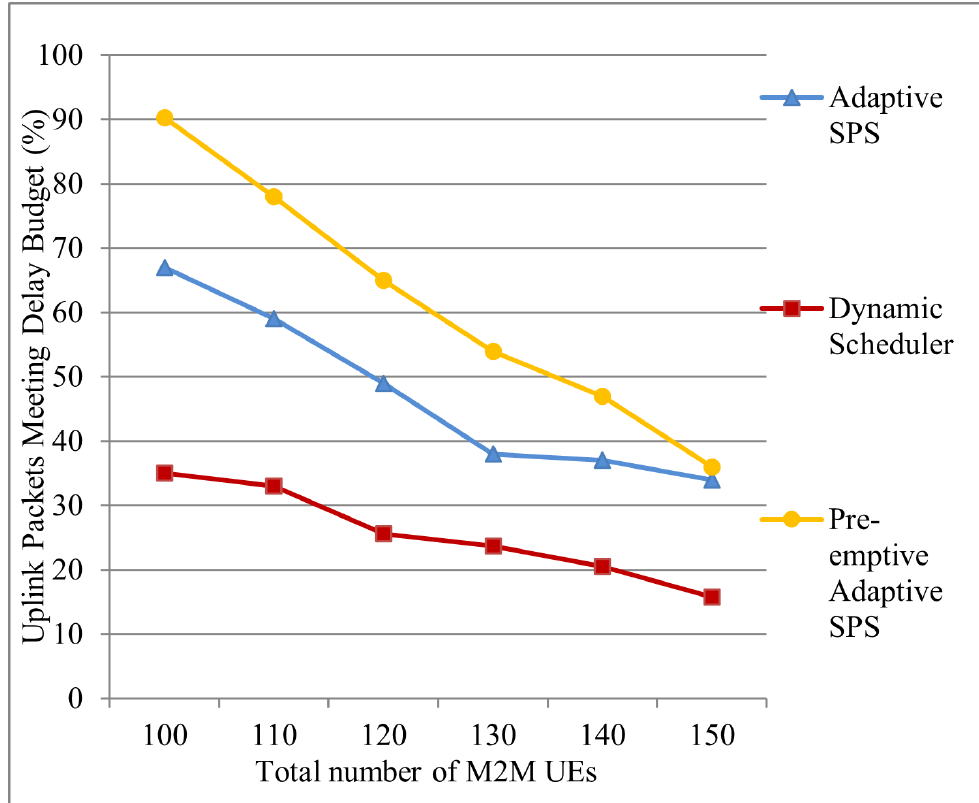
Figure 16. Percentage of packets meeting delay budget (150 UEs).